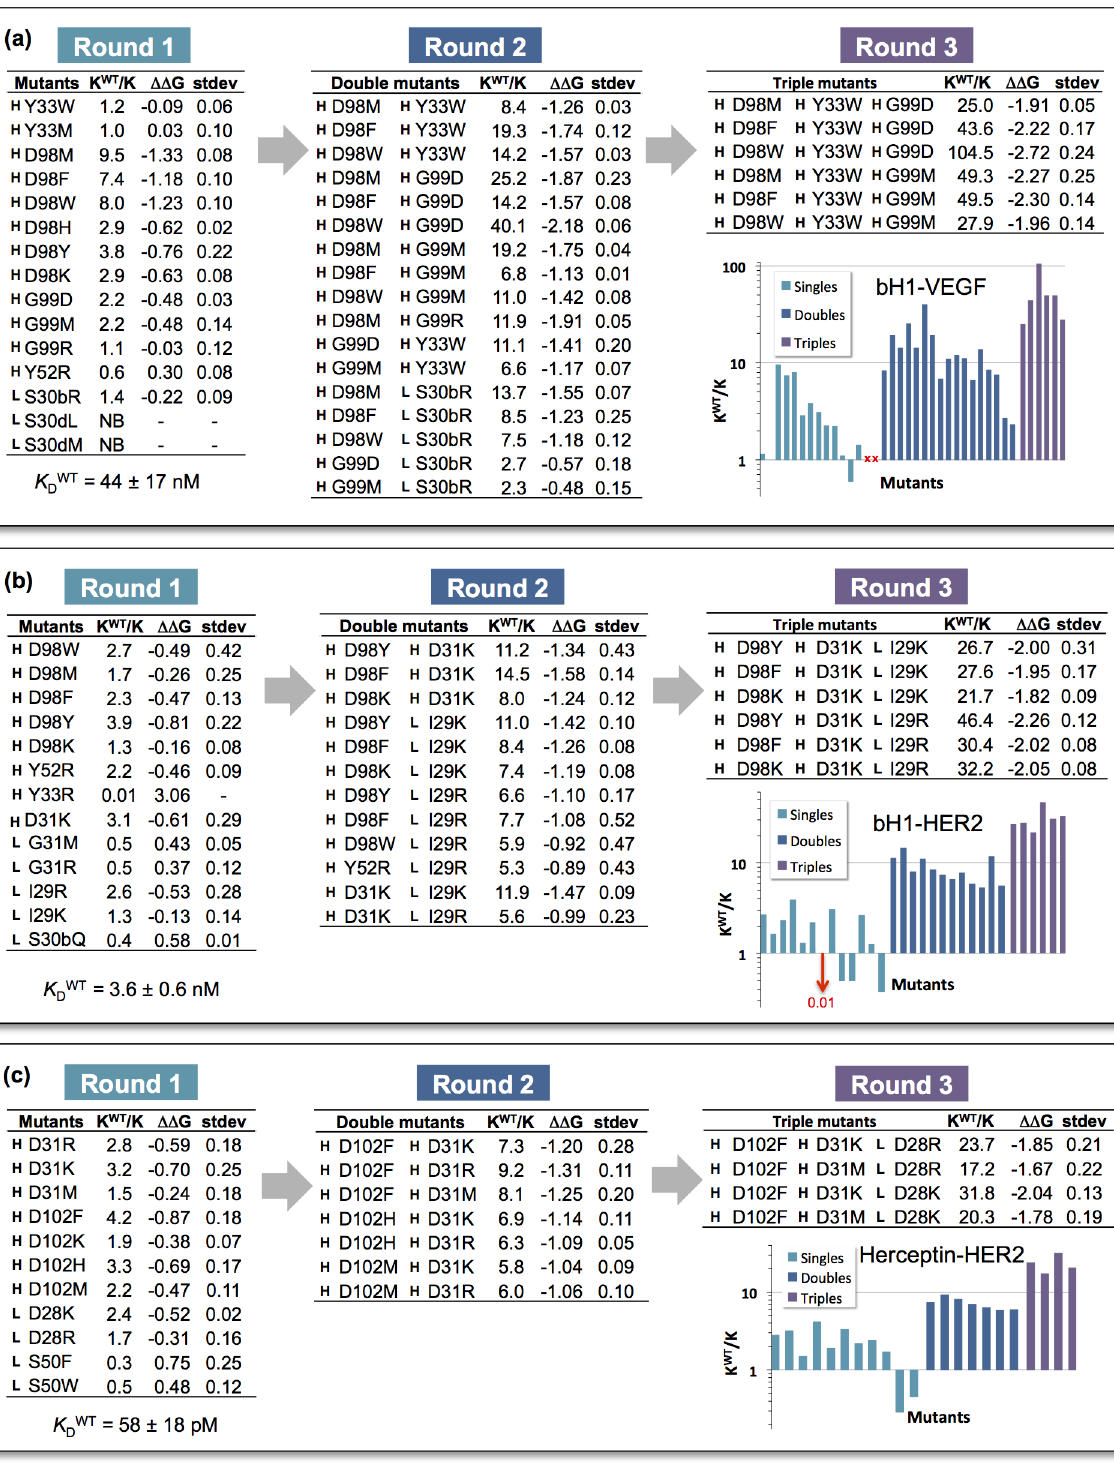
Fig 1. Fold improvements in binding affinity and relative changes in binding free energy (kcal/mol) relative to the parent Fab during three rounds of mutations. (a) bH1-VEGF. (b) bH1-HER2. (c) Herceptin-HER2. H and L designatethe mutation as being in the heavy or light chain, respectively.Standard deviations of ΔΔ G are basedon 3 or more replicates, typically. NB = no binding.WT = parent sequence.Residuenumberingfor bH1 follows that of Bostrom et al. [8] Residuenumberingfor Herceptinfollows that in the 1n8z PDB